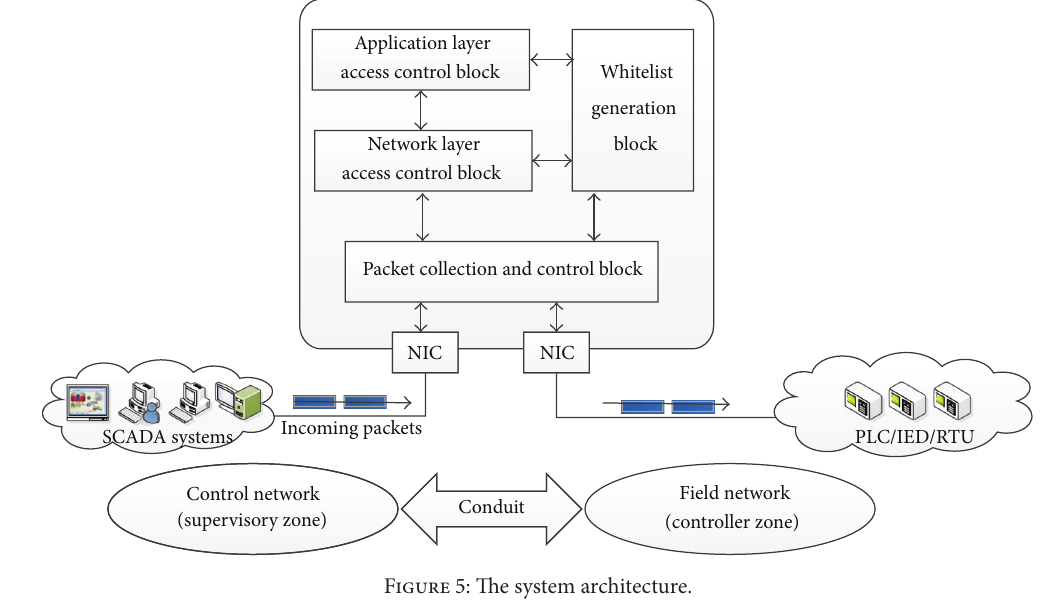
Figure 5: The system architecture.